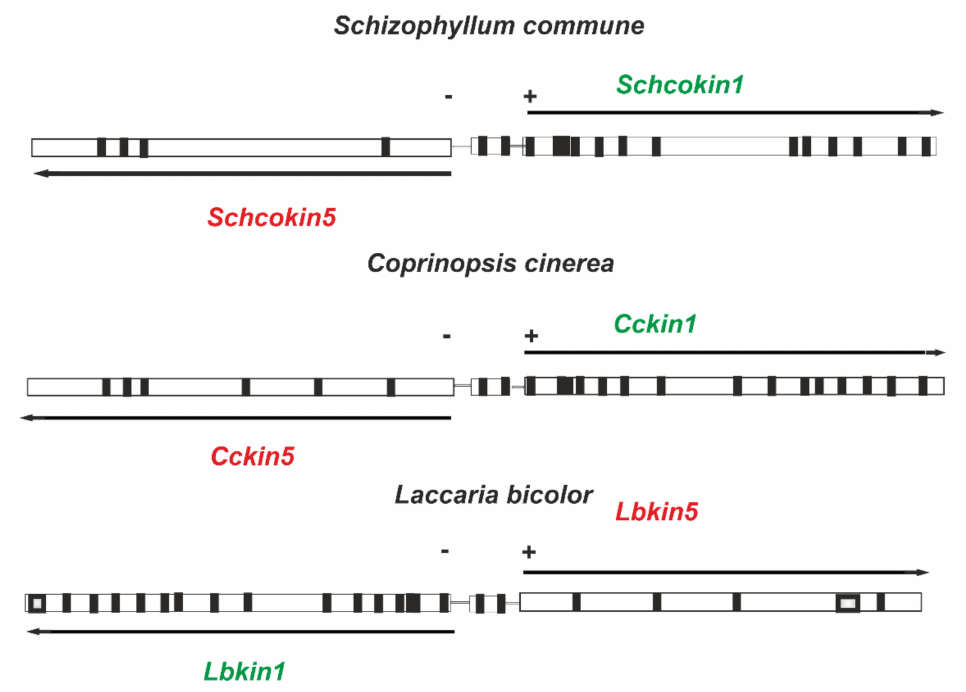
Figure 3. In the Schizophyllum commune genome ( Schizophyllum commune H4-8 v3.0) the genes Schco1 (encoding PID 2605236) and Schco5 (encoding PID2605230) are tightly linked. In the approximately 1000 bp intergenic region, a small gene of about 470 bp is located (PID 2605233) with two introns and a hypothetical function. Similar intergenic organizations between genes kin1 and kin5 occur, also in the Coprinopsis cinerea genome (https://mycocosm.jgi.doe.gov/Copci1/Copci1.home.html; accessed on 7 February 2022, kin1 PID 3681 and kin5 PID 3679) and Laccaria bicolor genome